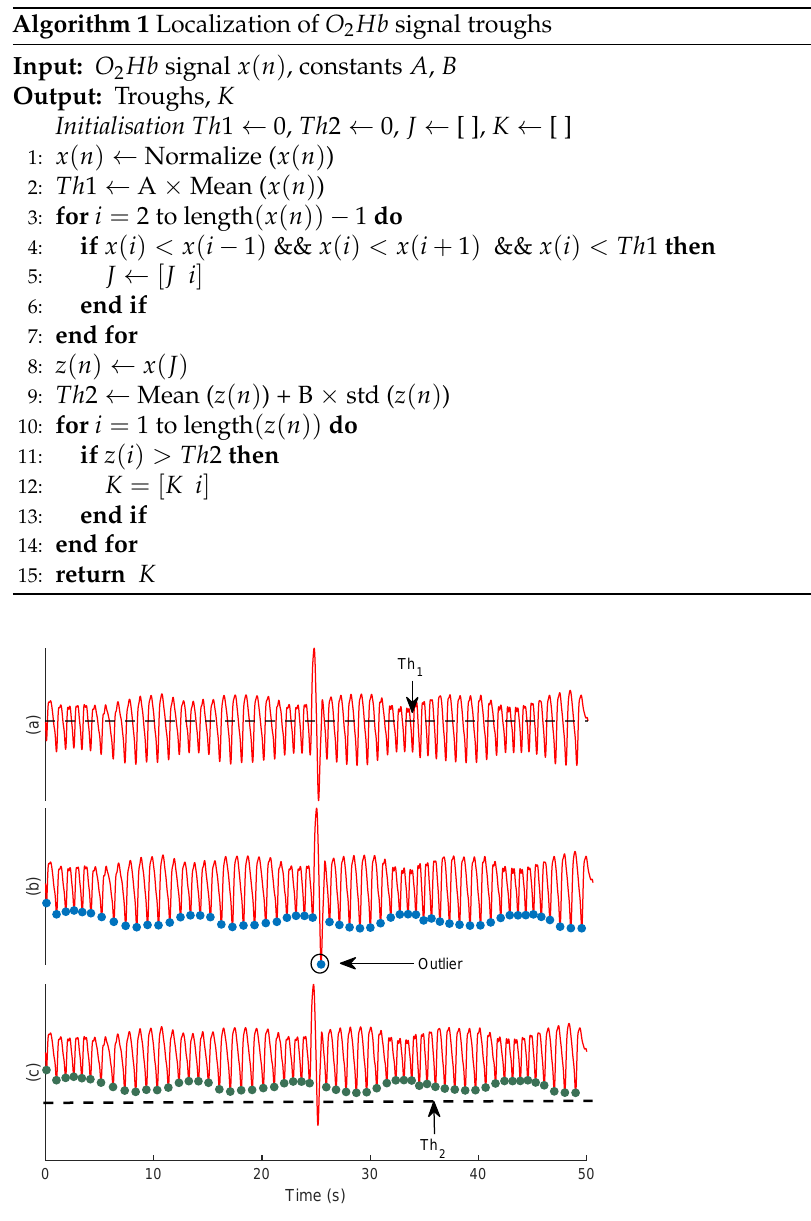
Figure 3. An example of the trough detection. The filtered O 2 Hb signal ( a ), the selected troughs after employing Th 1 ( b ), and Th 2 ( c